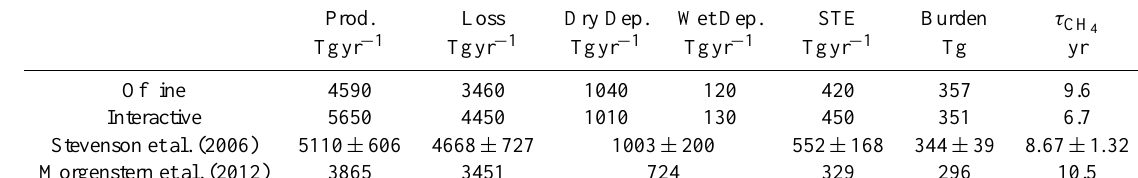
Table 3. Ozone Budget in the troposphere as defined by the tropopause of Hoerling et al. (1993) . Prod. Loss Dry Dep. Wet Dep.